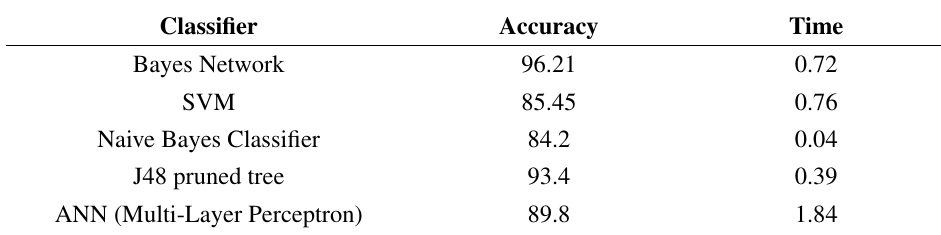
Table 9. Comparison of different classifier in activity recognition of the database (DB) of 120 min data using four essential features selected by the support vector machine (SVM)